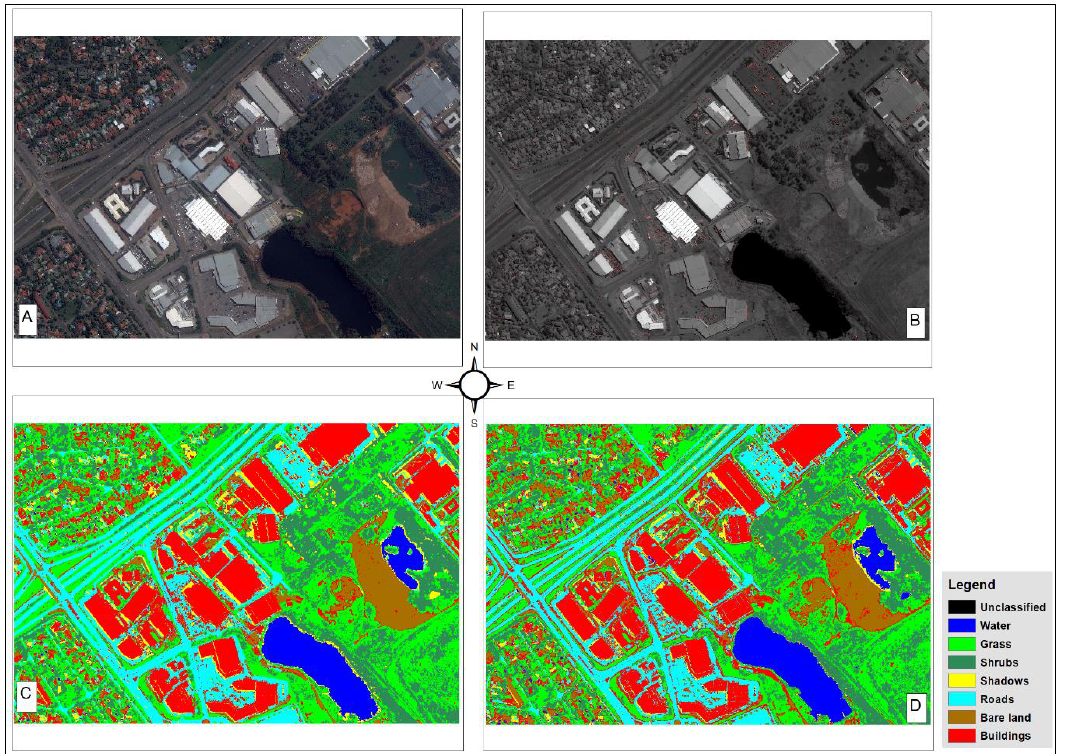
Figure 2. Pleiades image and classification results: (a) original Pleiades imagery; (b) filtered imagery using Morphological Profile (MP); (c) concatenation of morphological profiles (CMP) classified imagery; and (d) multi-morphological profiles (MMP) classified imagery.